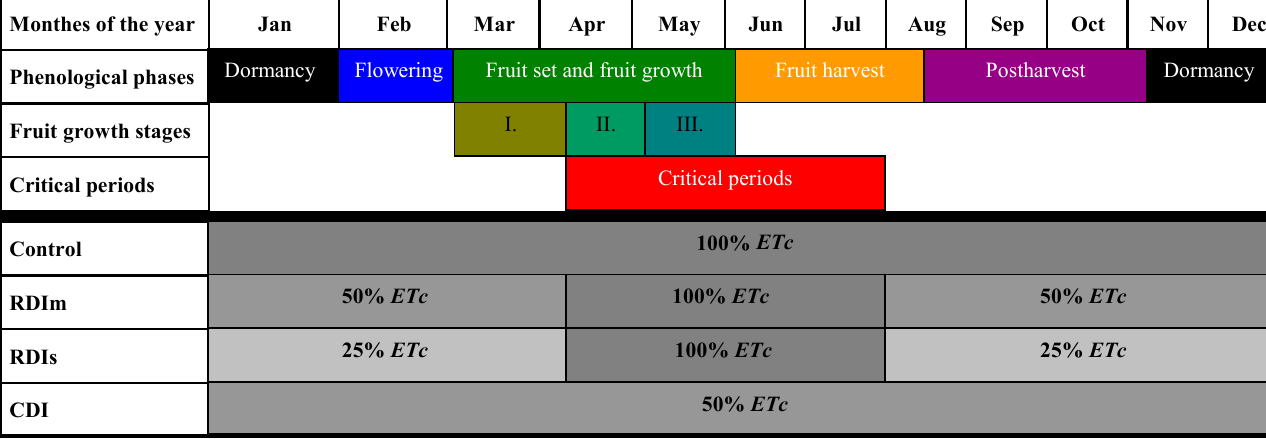
Figure 2. Experimental design for the four deficit irrigation treatments (Control, RDIm, RDIs, and CDI) of apricot trees according to the months of the year, tree phenological phases (dormancy, flowering, fruit set, fruit growth, fruit harvest, postharvest), fruit growth stages (I., II., III.), critical periods and the percent of crop evapotranspiration ( ETc ) of irrigation treatments at Wadi El Natrun, El Beheira Governorate, Egypt (2016–2018). Control = fully irrigated scheme, RDIm = moderate regular deficit irrigation, RDIs = severe regular deficit irrigation and CDI = continuous deficit irrigation. Table 2. The monthly irrigated water (L tree − 1 ) and overall annual irrigated water (L tree − 1 , m 3 ha − 1 ) for the four deficit irrigation treatments (control, RDIm, RDIs, and CDI) of apricot trees at Wadi El Natrun, El Beheira Governorate, Egypt (2016–2018). Explanation for Control, RDIm, RDIs, and CDI are given in Figure 2.